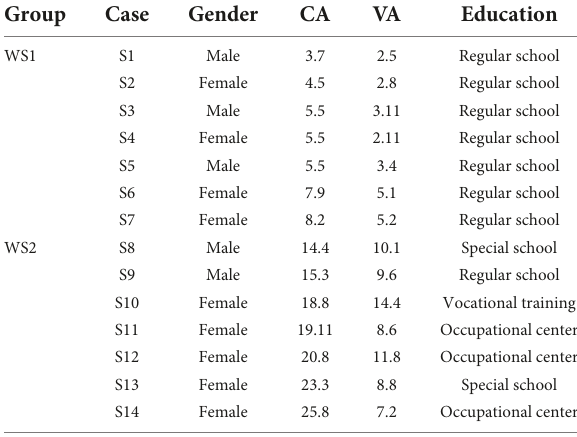
TABLE 1 Gender, chronological and verbal age, and education of the participants with Williams